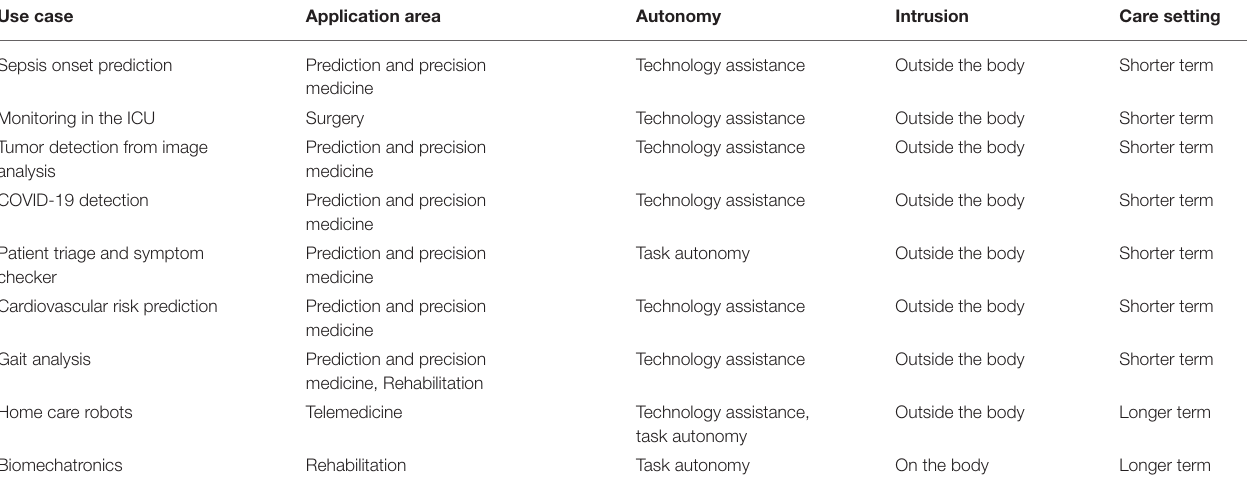
TABLE 2 | Mapping of use cases to our